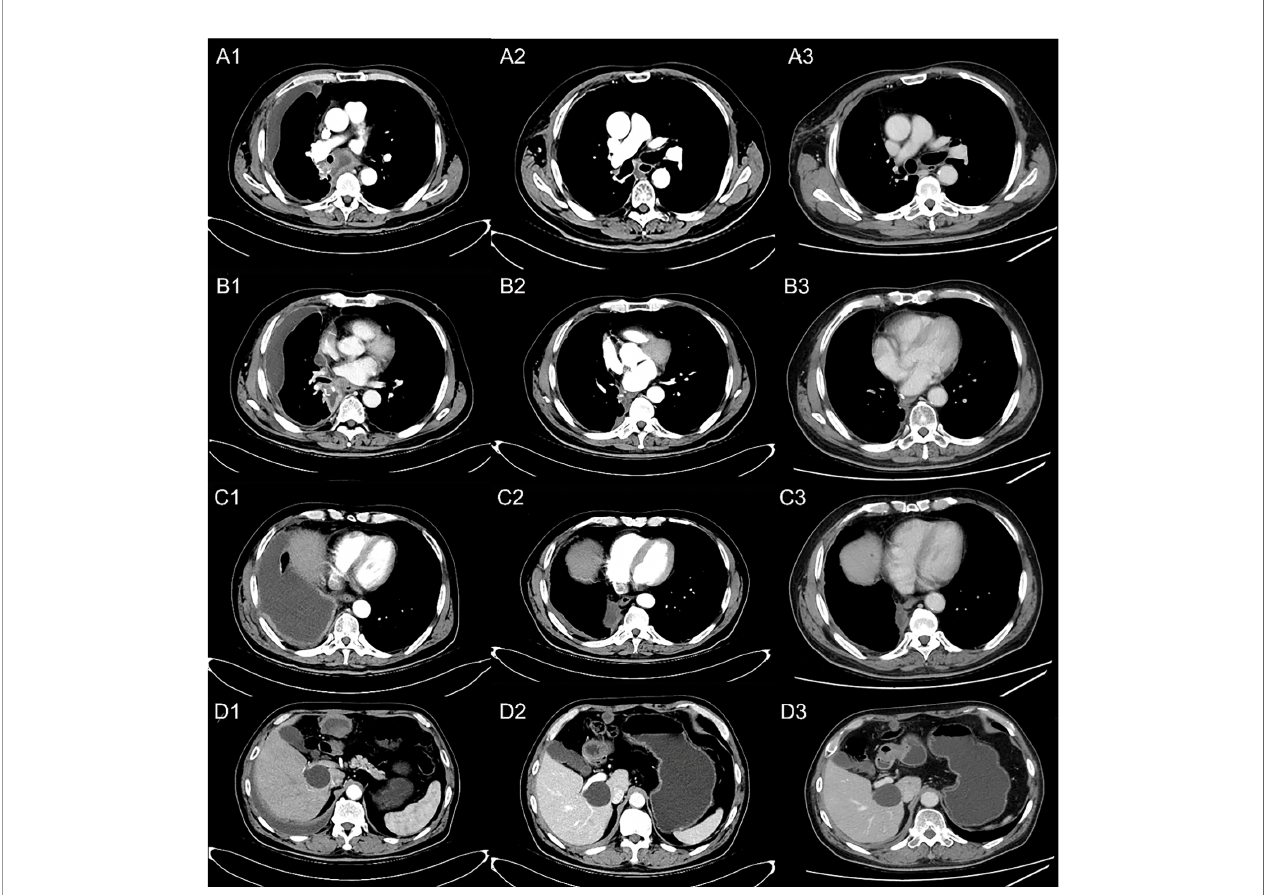
FIGURE 4 | Reexamination results showing tumor regression by contrast-enhanced CT scan. (A) Occupation in mediastinum; (B) thickening of the right pleura; (C) soft tissue by the side of the right bronchial stump; (D) metastatic lesion on the right upper abdomen. (A1, B1, C1, D1) PD after one cycle of fi rst-line chemotherapy; (A2, B2, C2, D2) disease PR after two cycles of the second-line treatment; (A3, B3, C3, D3) disease remaining as PR after four cycles of the second-line